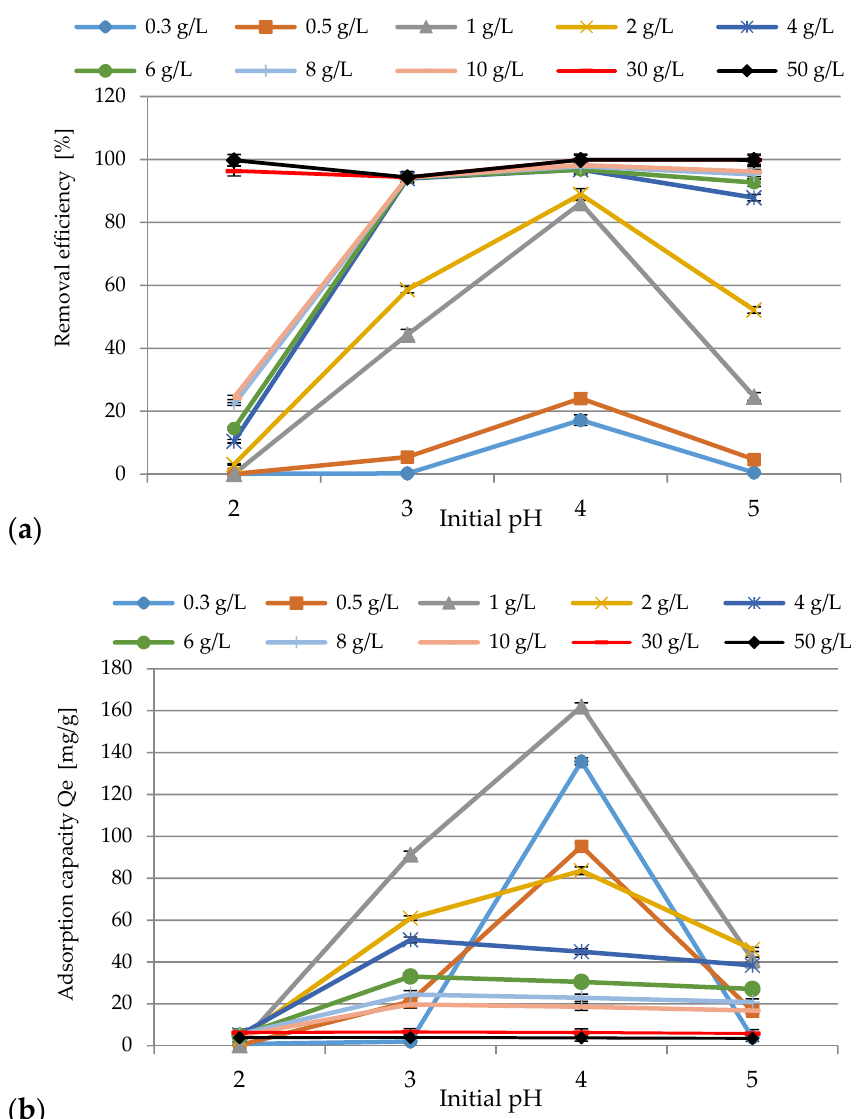
Figure 6. The effect of initial pH on removal efficiency ( a ) and adsorption capacity ( b ) of Ni(II) ions with SS-FA.